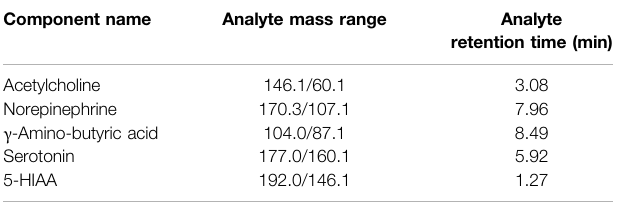
TABLE 1 | Information on all ion pairs of